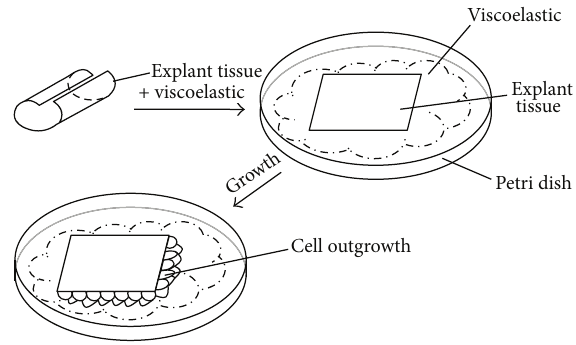
Figure 1: Method for adherent ex vivo cultivation of human eye tissue explants in a cell culture Petri